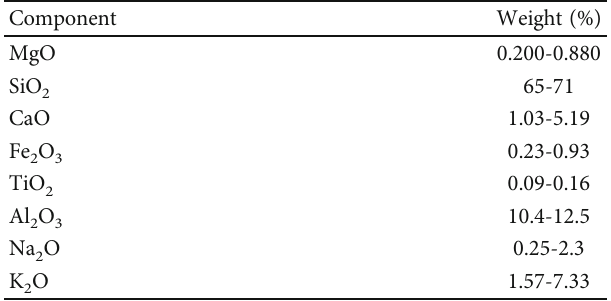
Table 2: Chemical components of BS used in this